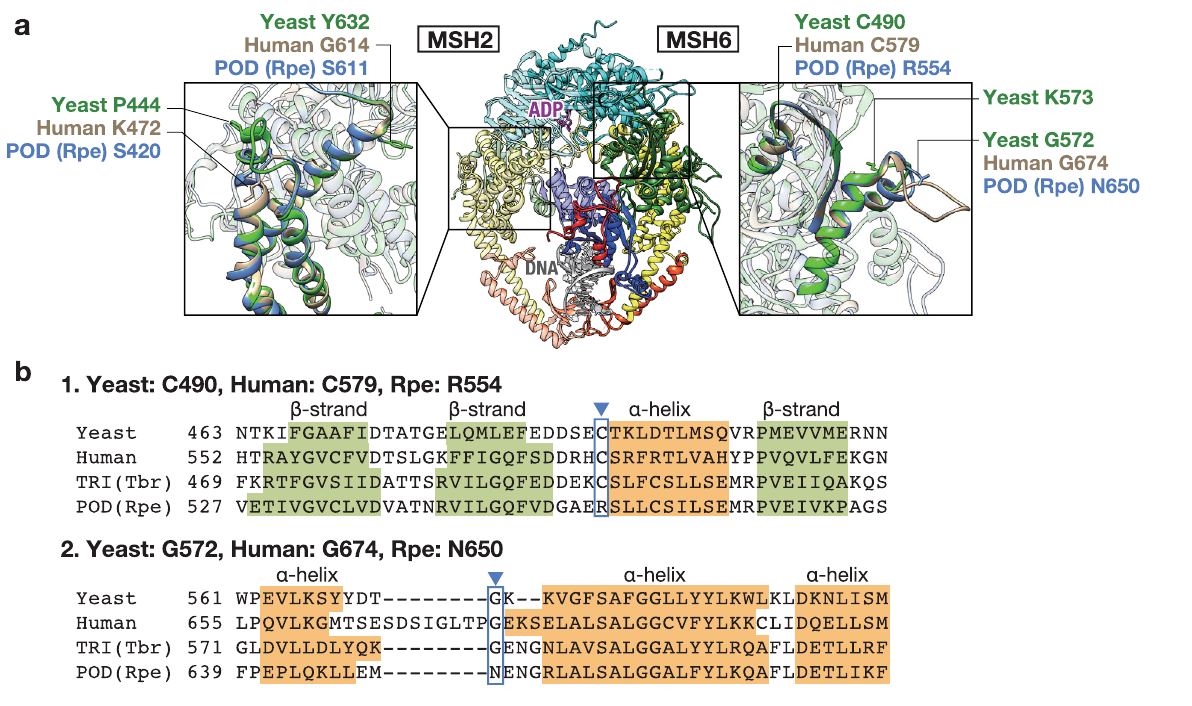
Fig. 5 Prediction of Podostemaceae MSH2/MSH6 complex structures. a Superimposed three-dimensional models of yeast and Podostemaceae MSH2 (left) and MSH6 (right) proteins with human MutS α (MSH2/MSH6) bound to ADP and DNA strands (PBD ID: 2O8B). Red: disordered domain, green: connector domain, blue: mismatch binding domain, yellow: lever domain, orange: clamp domain, light blue: ATPase domain. The inset fi gures show magni fi cations of the regions around the positively-selected sites. The structure of the Rhyncholacis cf. penicillata (Podostemaceae) MSH2/MSH6 is shown in blue, with human MSH2/MSH6 in silver, and yeast MSH2/MSH6 in green. b MSH6 alignment of the regions around the fi rst and second positively- selected sites (arrowheads). Predicted secondary structures are shown. POD Podostemoideae, Rpe Rhyncholacis cf. penicillata , Tbr Terniopsis brevis , TRI